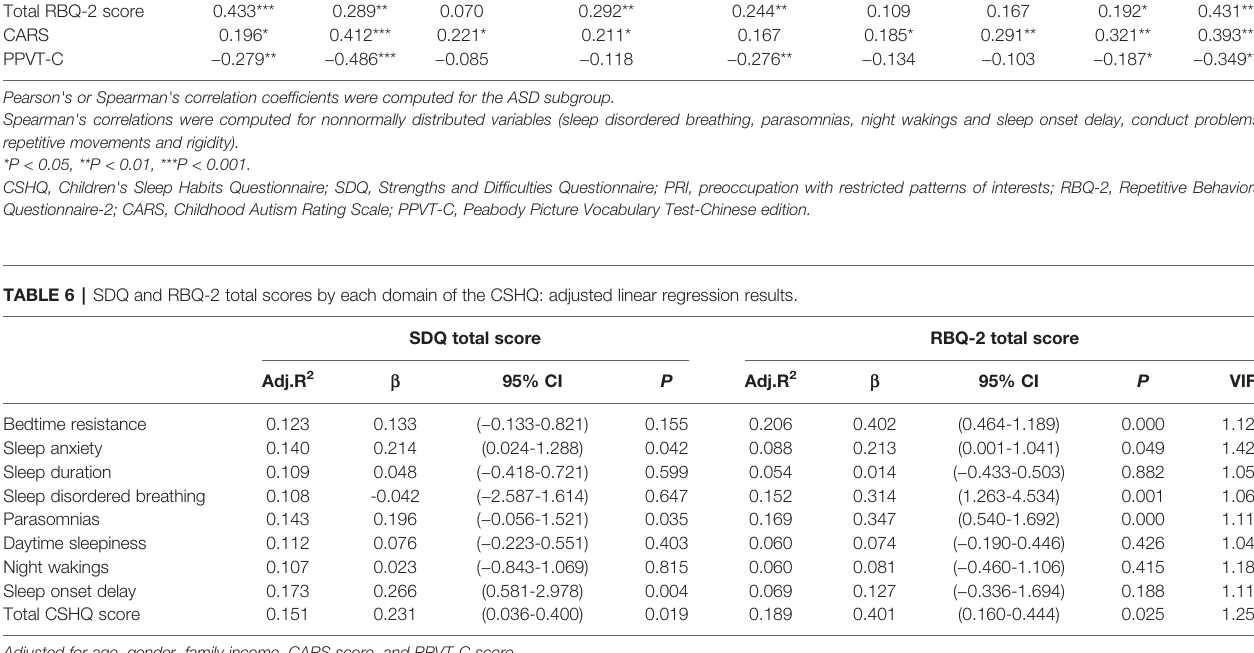
TABLE 5 | Relationships between the CSHQ and the SDQ, RBQ-2 domains, CARS, and PPVT-C. Emotional symptoms